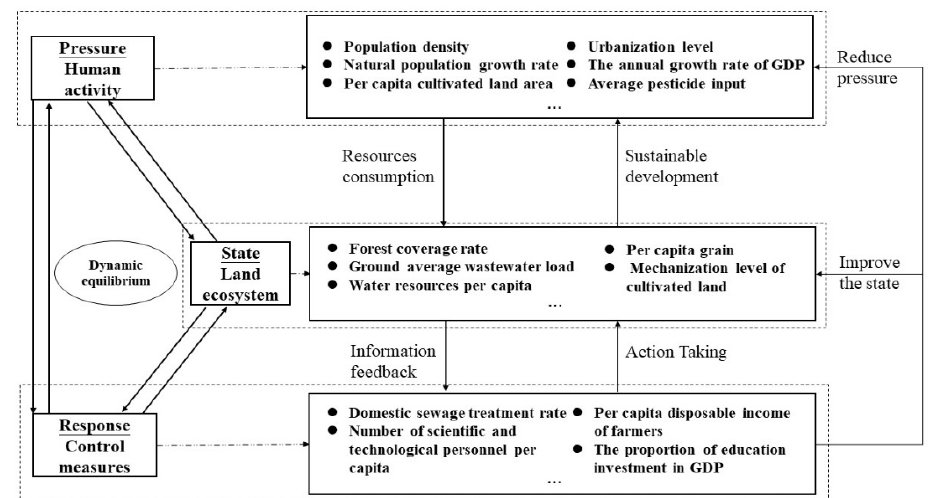
Figure 2. Operational mechanism of the PSR model.